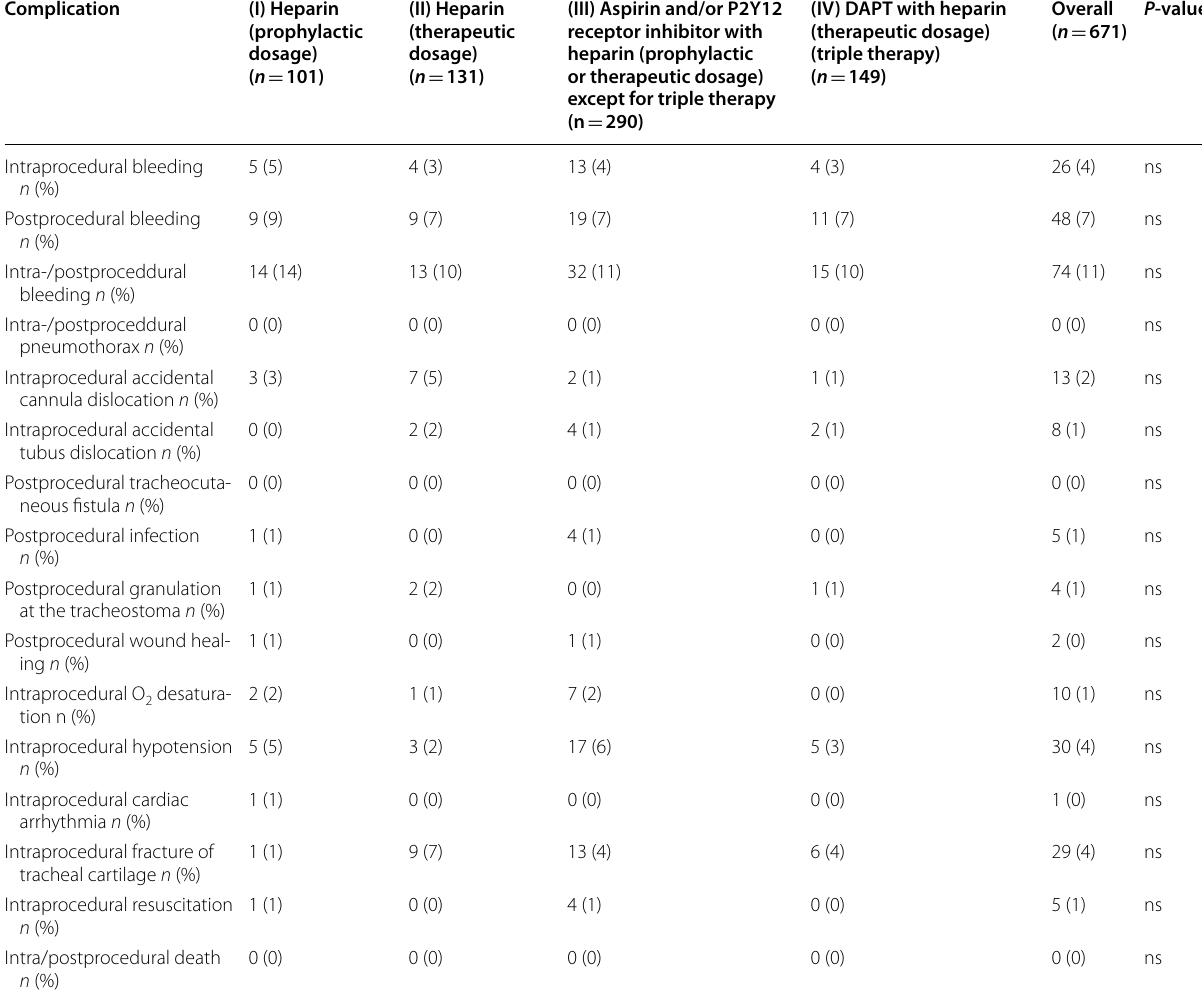
Table 2 Procedural related complications during and after PDT differentiated by treatment group